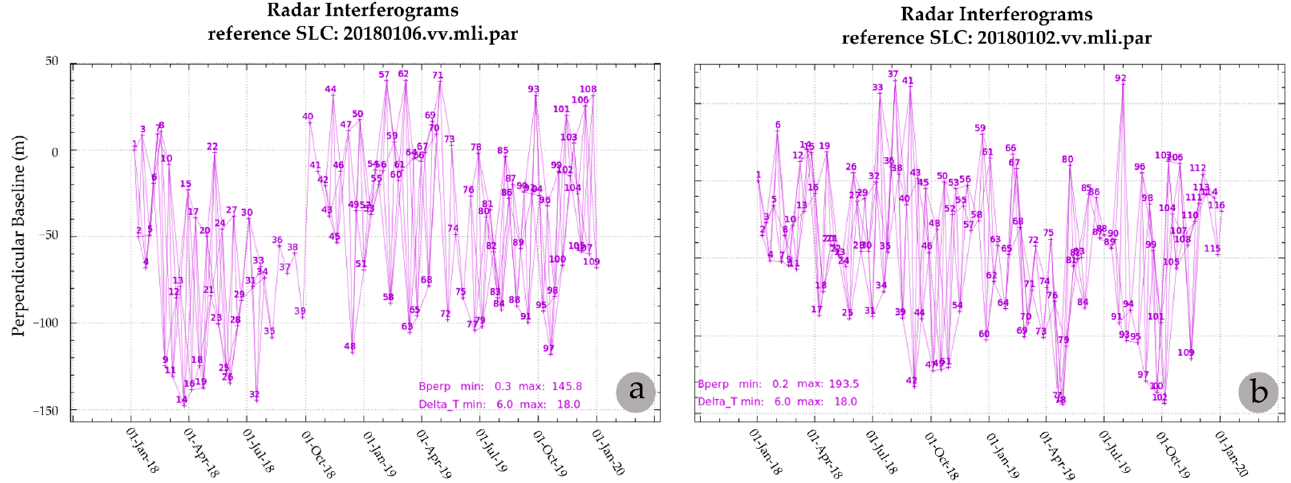
Figure 4. Temporal and spatial (perpendicular) baseline connection diagram of the Sentinel-1 SLC image pairs from ( a ) ascending and ( b ) descending orbital pass used in the DIS approach.